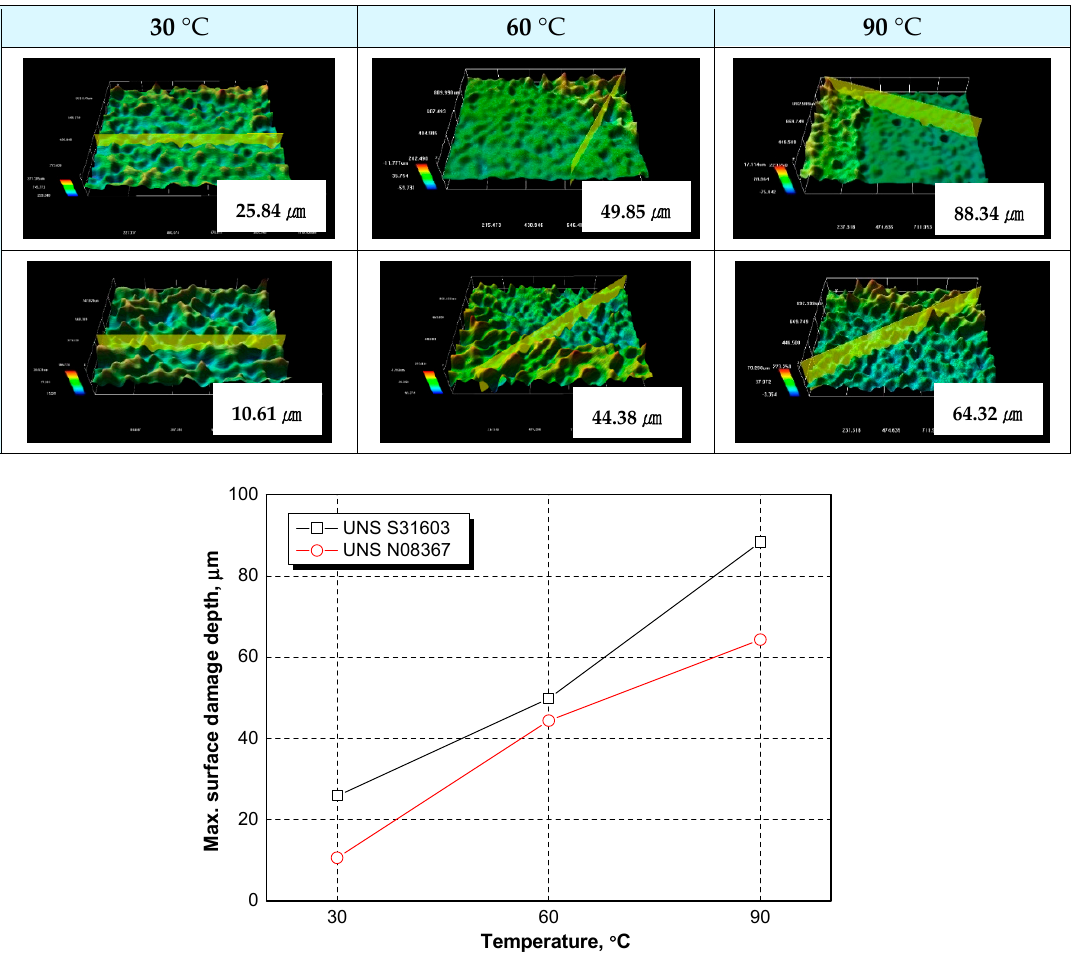
Figure 8. Surface damage depths of UNS S31603 and UNS N08367 after the electrochemical experi- ments in a modified green death solution with temperatures.